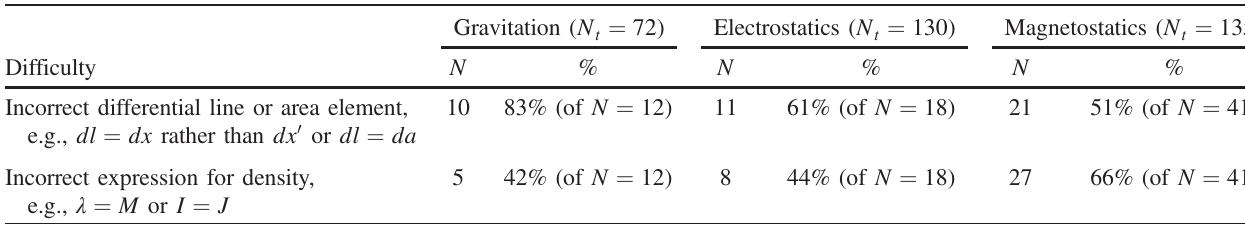
TABLE II. Difficulties expressing the differential element (i.e., dm , dq , or JdV 0 ). Each N column gives the number of students who were coded as having a given error. This is also given as a percentage of the overall students who were coded as having difficulty with element C2% column ( N given in parentheses). For completeness, N represents the total number of solutions that included at t least one element of construction. Codes are not exhaustive or exclusive (so percents may not total to 100%) but represent the most common